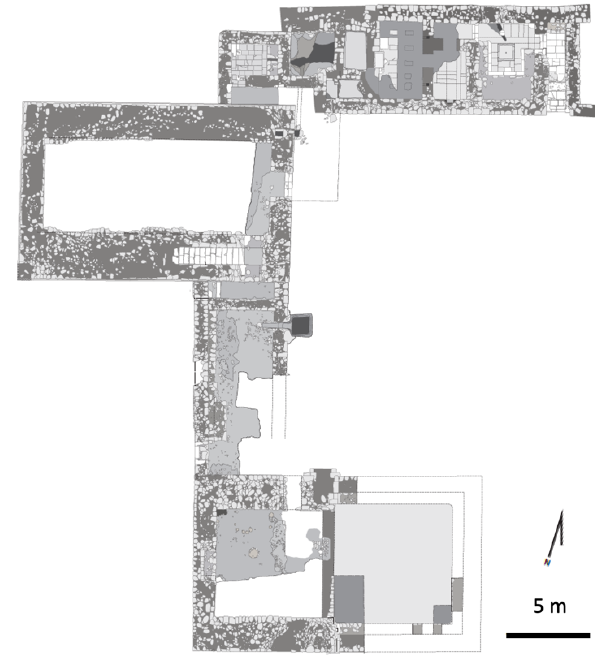
Figure 8: Khirbat al-D ū saq, general plan of the site (2018 ©Mission Kh. Al-Dusaq, / drawing R. Elter, photogrammetry E.